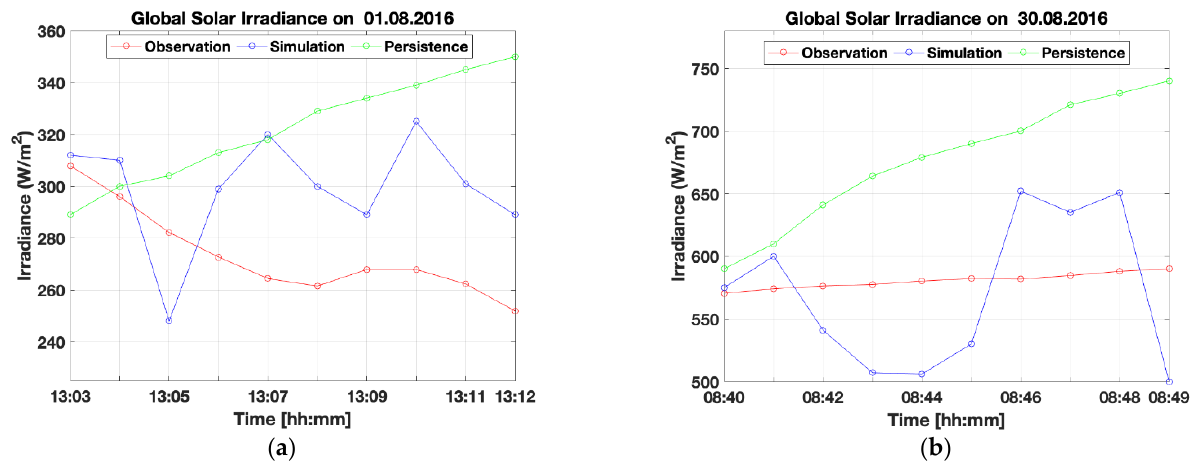
( f ) Figure 4. Comparison between the observed images and simulated images one-minute ahead generated as output by the CNN and their correspondent measured and simulated global horizontal irradiance (GHI) values; ( a ) corresponds to 24 August 2014 at 09:45 with ( b ) as its simulations; ( c ) corresponds to 8 June 2015 at 15:10 with ( d ) as its simulations; ( e )